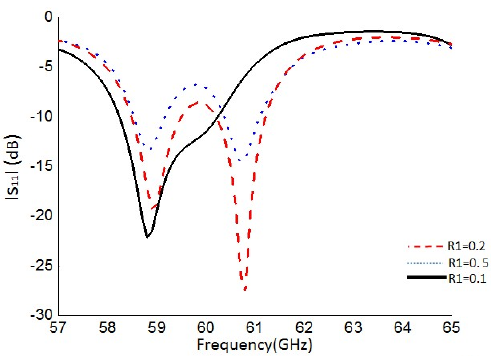
Figure 7. Simulated return loss for the proposed antenna with various distances between the double T-shapes (unit in mm).